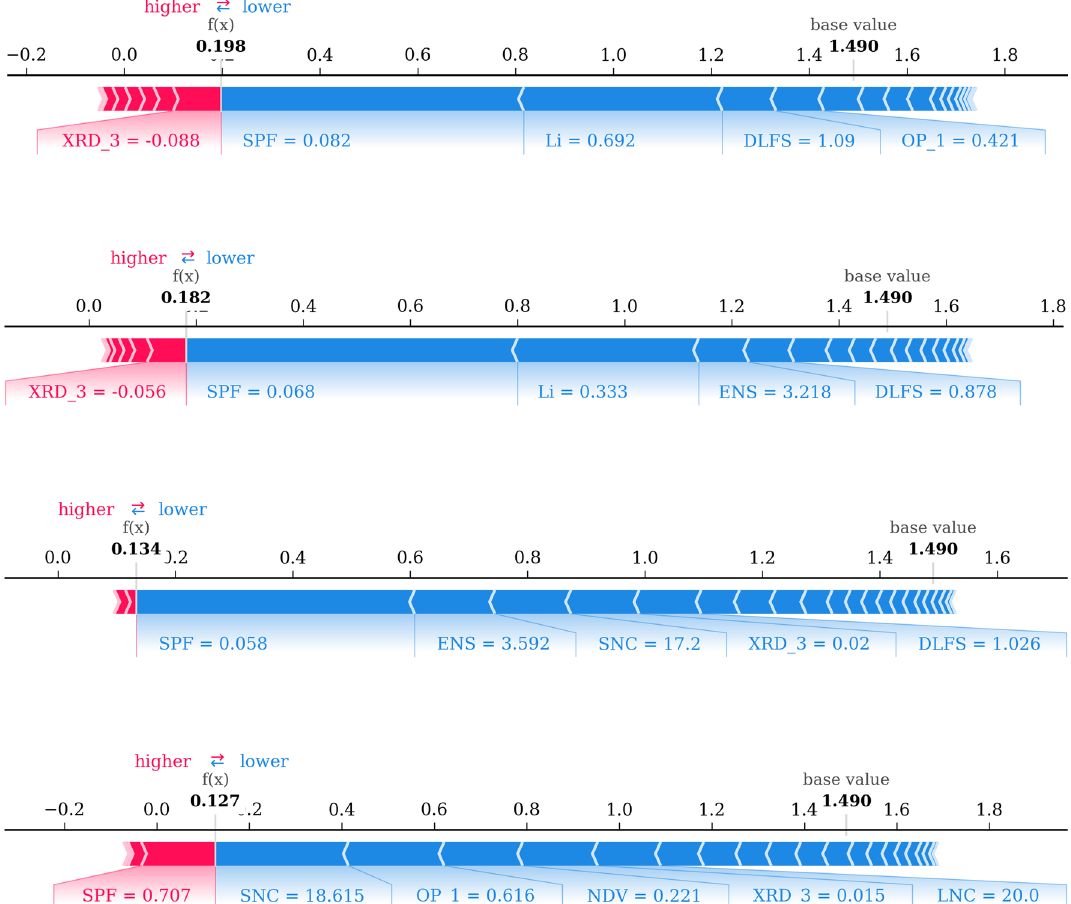
Figure 2. Shapley explanations for individual predictions made by the GB model trained on 3D barriers. Red arrows represent feature effects that drive the predicted 3D barrier higher, while blue arrows represent those that drive the prediction lower. The lengths of the arrows indicate the magnitudes of the effects. From top to bottom: Li 9 S 3 N , Li 2 CO 3 , LiBF 4 , and Sr 4 Li ( BN 2 ) 3